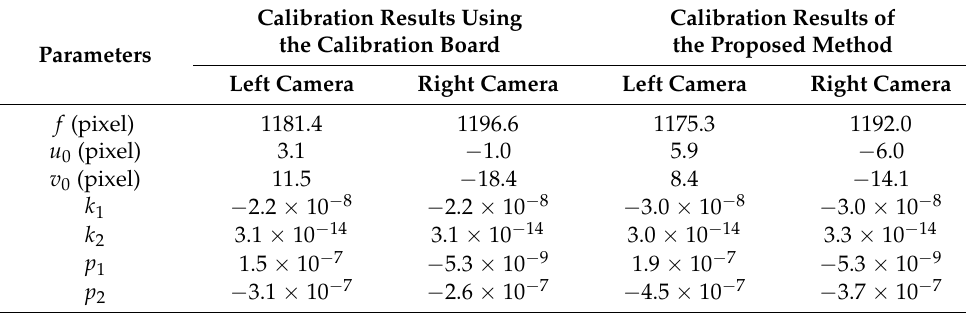
Table 4. Calibration results of the navigation cameras.